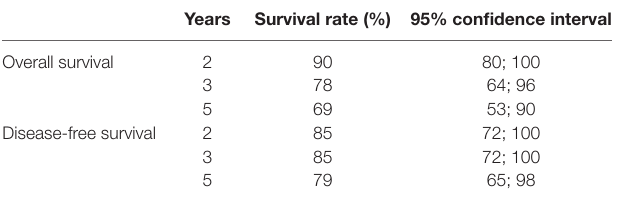
Table 5 | Kaplan–Meier estimates of survival for stages I and